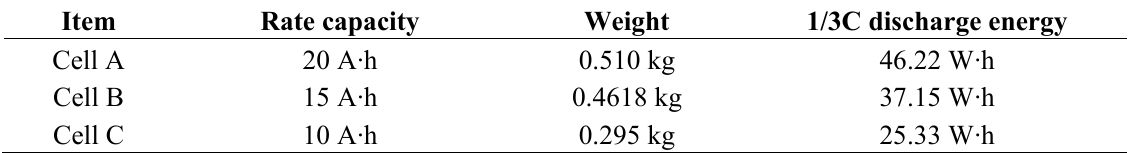
Table 1. Basic parameters of the three